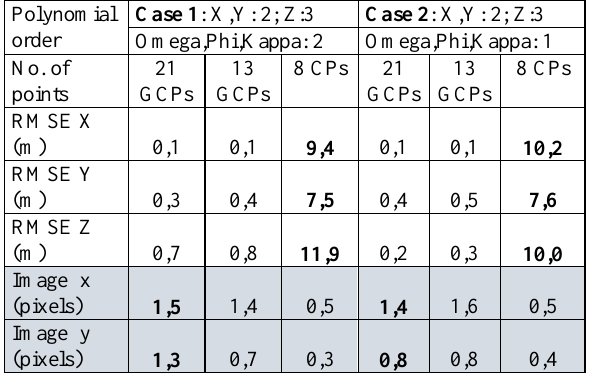
Table 6. Triangulation results, part-1.